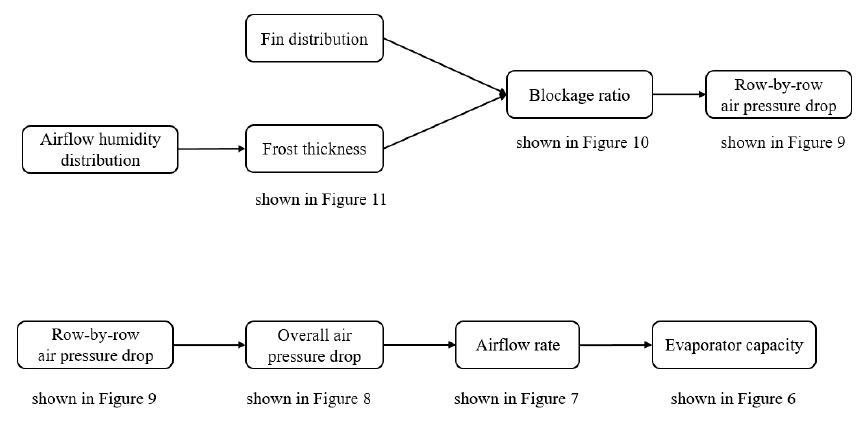
Figure 12. The logical frame of the optimization method. Table 5. Different temperature and humidity conditions of frontal air